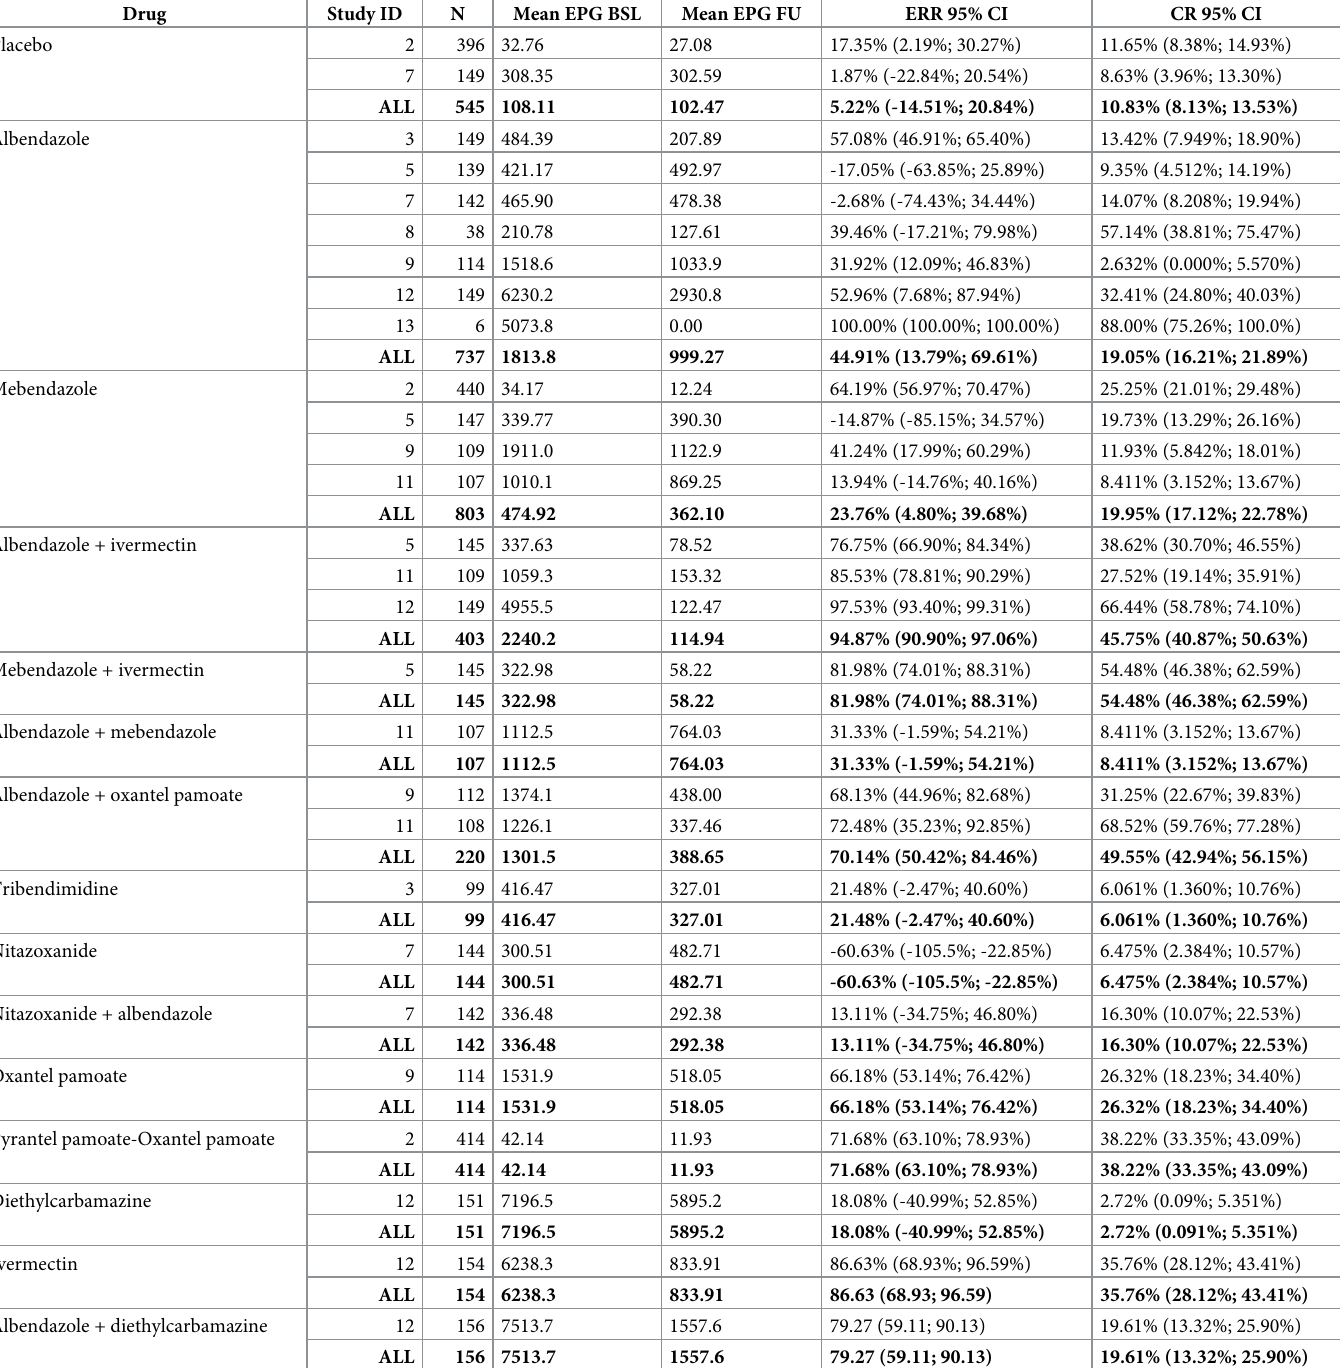
Table 5. Egg count arithmetic means before and after treatment and drug efficacy outcomes (group egg reduction rate, ERR) for studies with follow-up duration between 14 and 21 days for Trichuris trichiura .